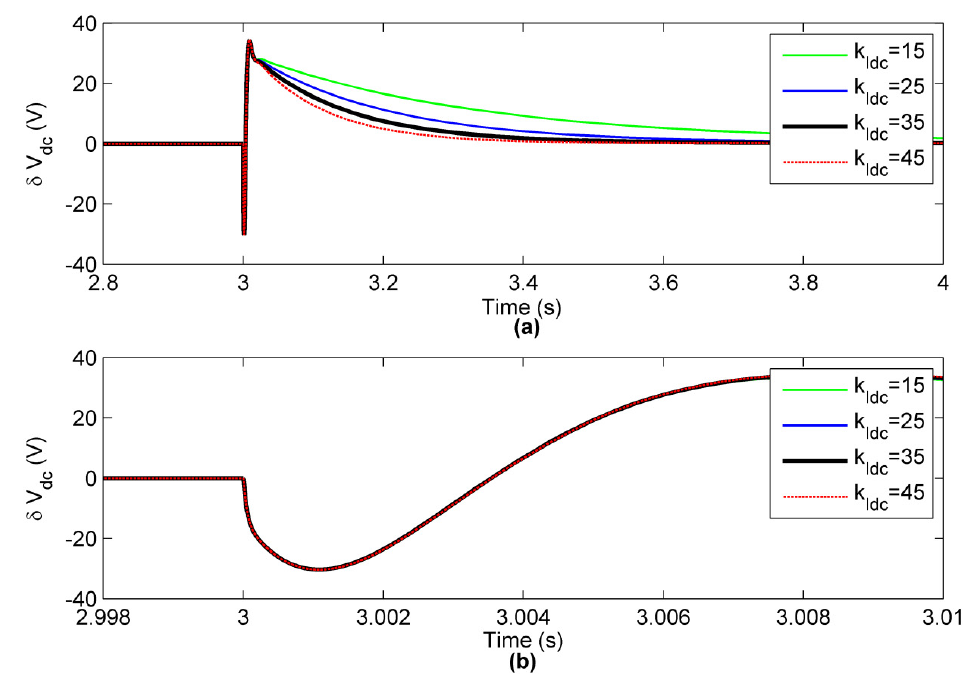
Figure 12. ( a ) The dc-link voltage variation by increasing k Idc in 50% voltage drop in grid; and ( b ) zoom of starting time of variation.